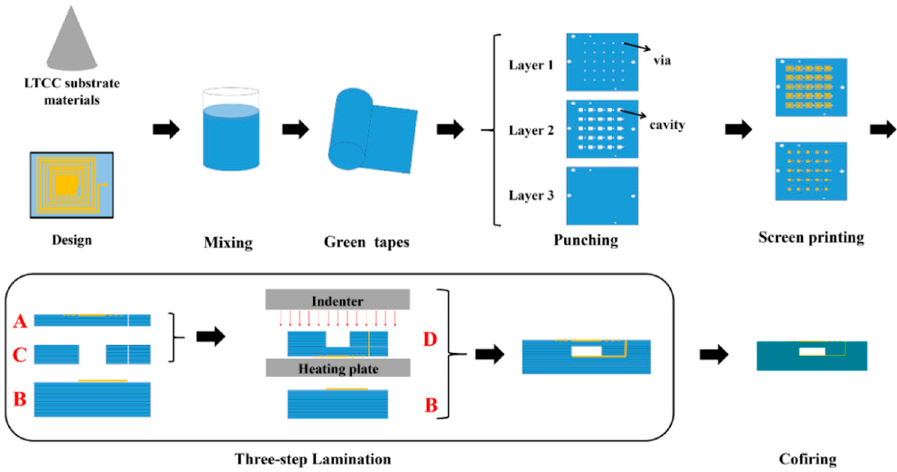
Figure 3. Fabrication process of the wireless LTCC pressure sensors.